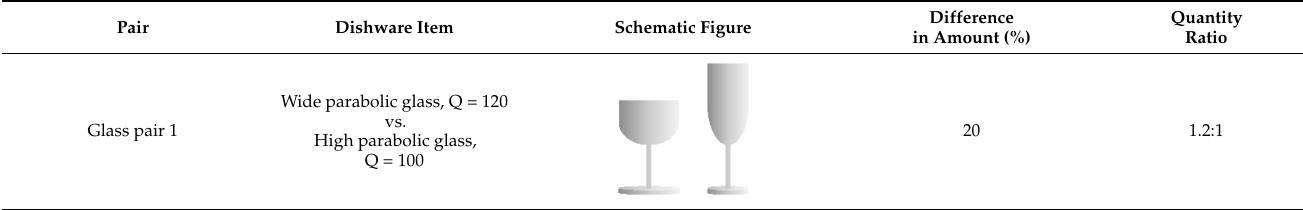
Table 2. Characteristics of dishware